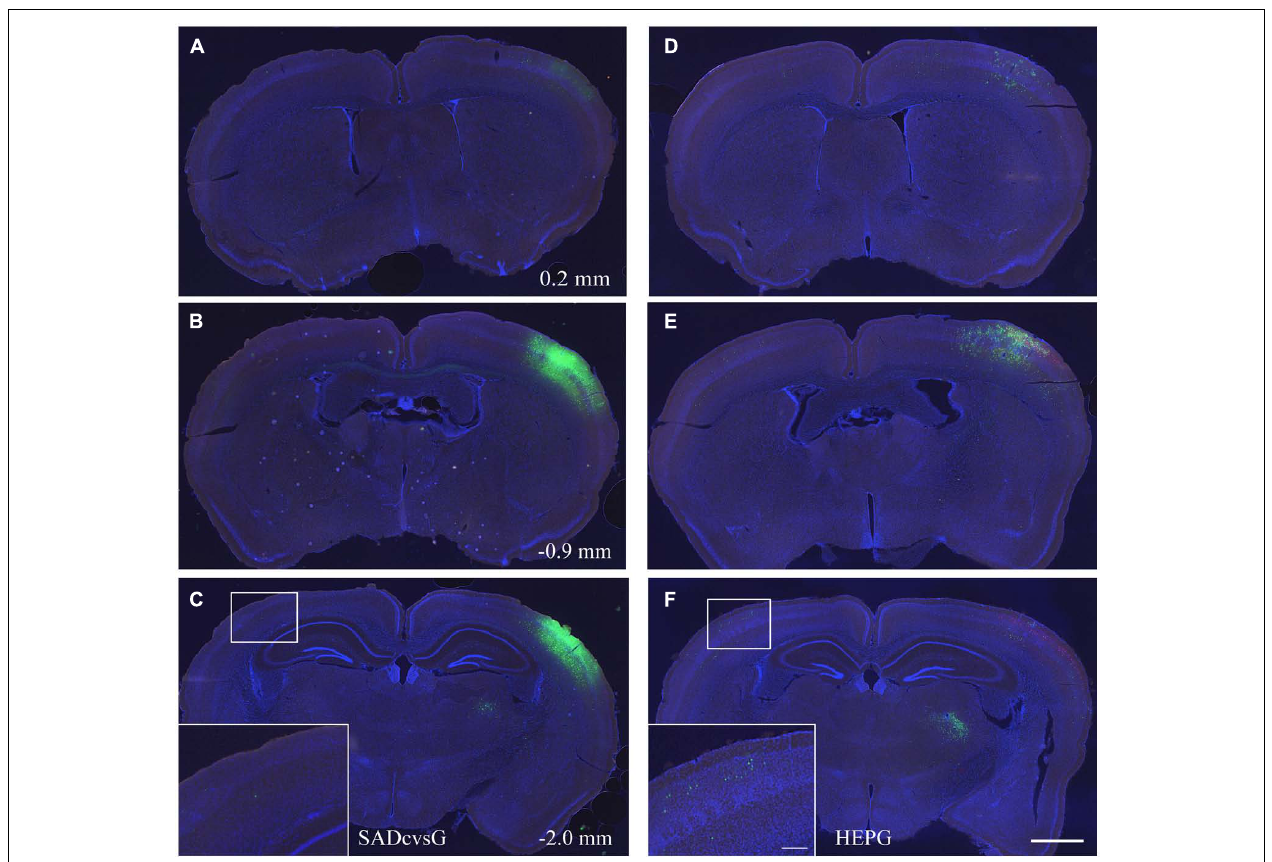
FIGURE 5 | Distribution of presynaptic cells traced with SADcvsG and HEPG. Distributions of presynaptic neurons traced with (A–C) SADcvsG and (D–F) HEPG in brain slices at three different levels of the anterior–posterior (AP) axis.The AP position was indicated as a distance from Bregma in